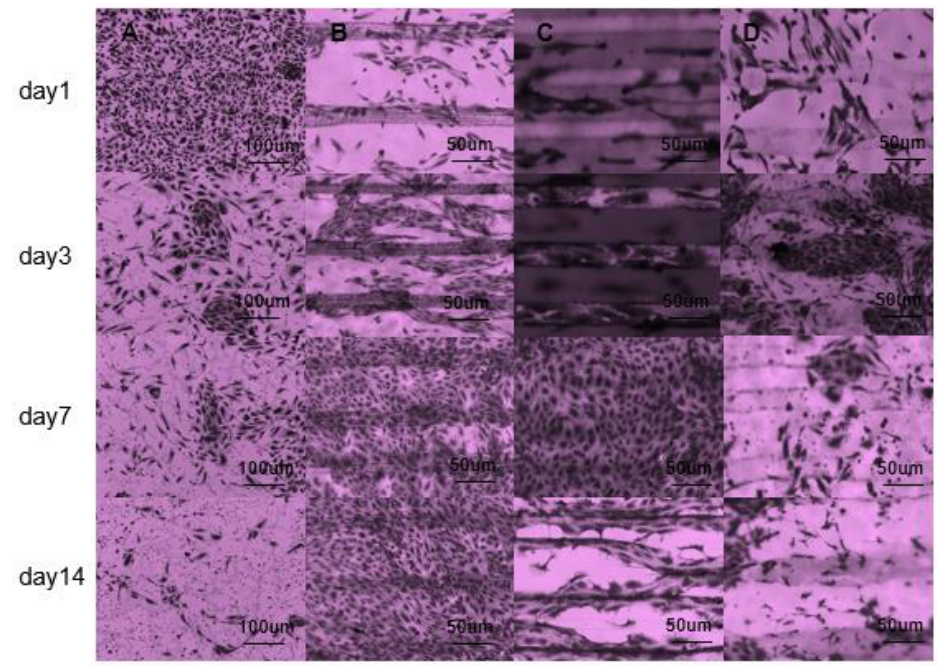
Figure 7. Growth of cells inoculated in two weeks: ( A ) unstructured PPDO film group, ( B ) pcl gelaTable, ( C ) pcl gelatin direct writing compound group, and ( D ) pcl direct writing compound group.